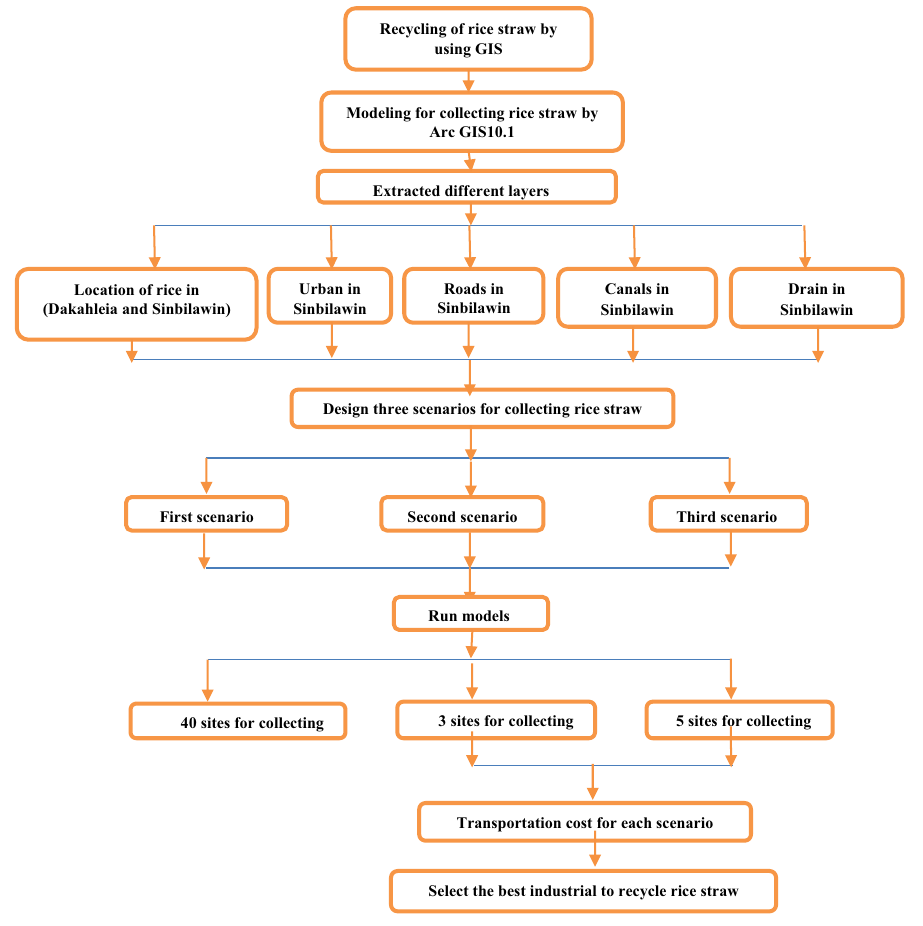
Figure 3. Flowchart of rice straw collecting from Sinbilawin